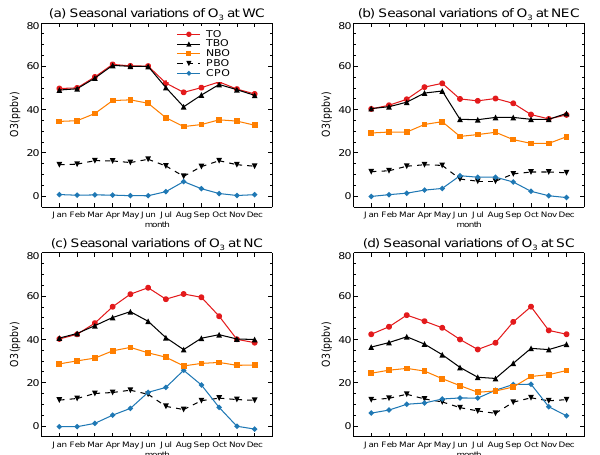
Fig. 9. Monthly variations of mean surface ozone (TO, red cir- cles), total background ozone (TBO, solid line with black upward triangles), natural background ozone (NBO, orange squares), pol- lution background ozone (PBO, dotted line with black downward triangles), and China pollution ozone (CPO, blue diamond) for dif- ferent Chinese regions. The unit is ppbv. The regions are defined in Fig. 5a.